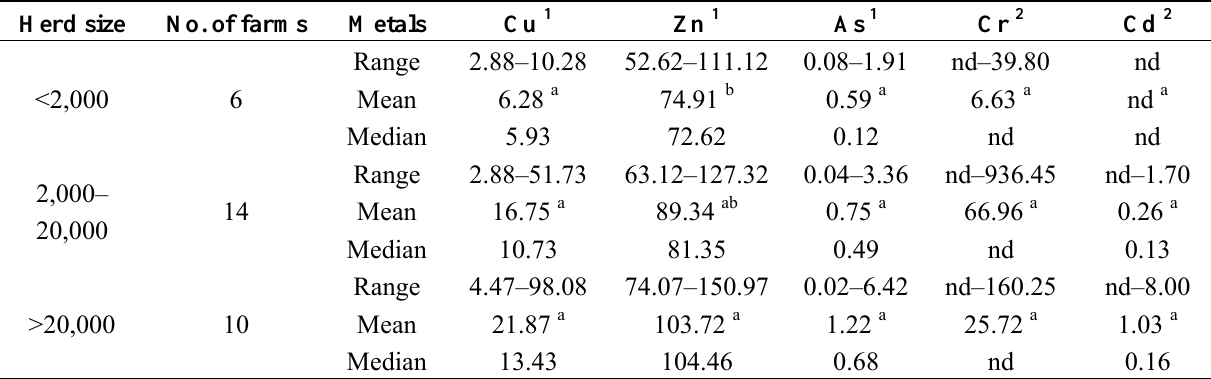
Table 3. Heavy metals in chicken feed from farms of different herd size (mg/kg dm). Herd size